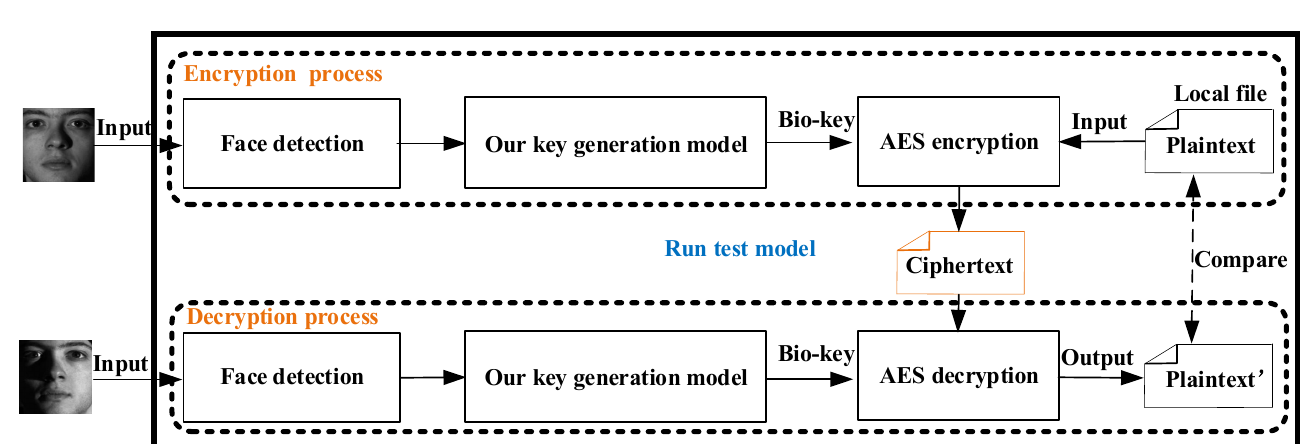
Figure 9. Illustration of encryption and decryption process on the personal computer platform.